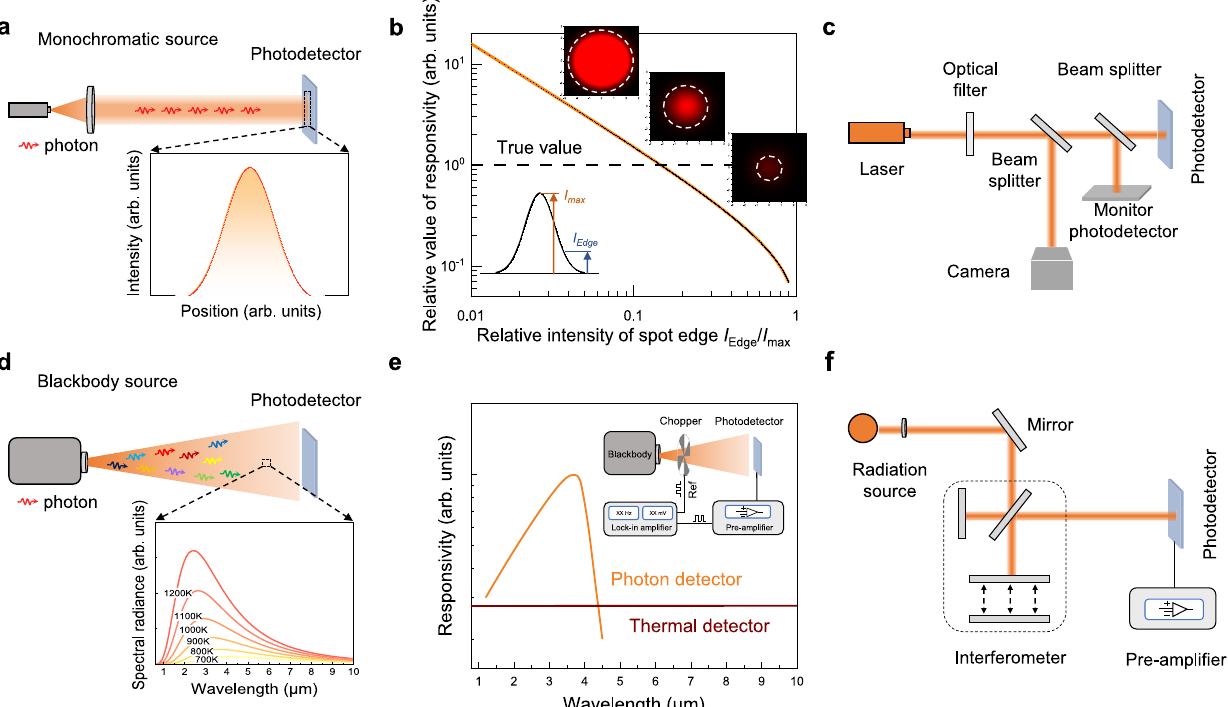
Fig. 3 | Responsivity and response spectrum determination of 2D photo- detectors. a Monochromatic laser source measurement system, where the laser spot intensity follows the Gaussian distribution. b Relative intensity of the edgeof the spot under the researcher ’ s estimation. The inset shows three spots with the